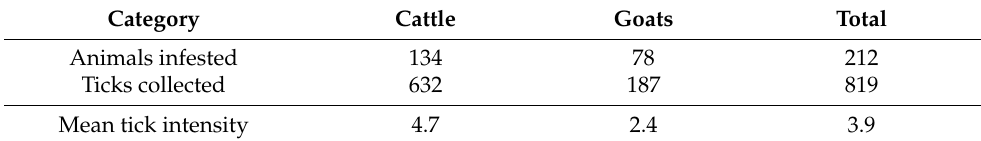
Table 2. Mean ticks intensity in cattle and goats b .